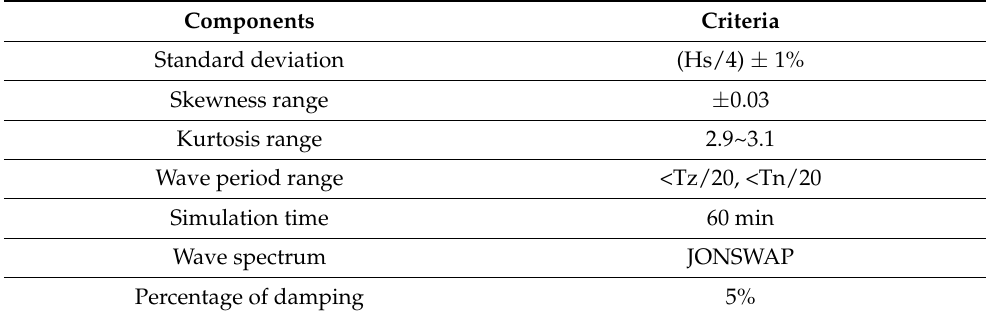
Table 3. Random wave analysis